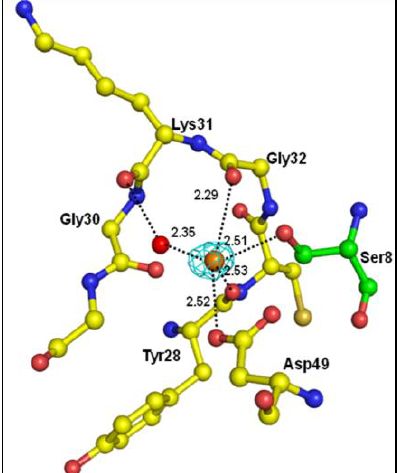
− F | electron density for the calcium ion drawn at 2σ. Calcium Figure 4. Difference |F c o coordinated interactions are indicated by dotted lines. Ser8 of peptide is shown in